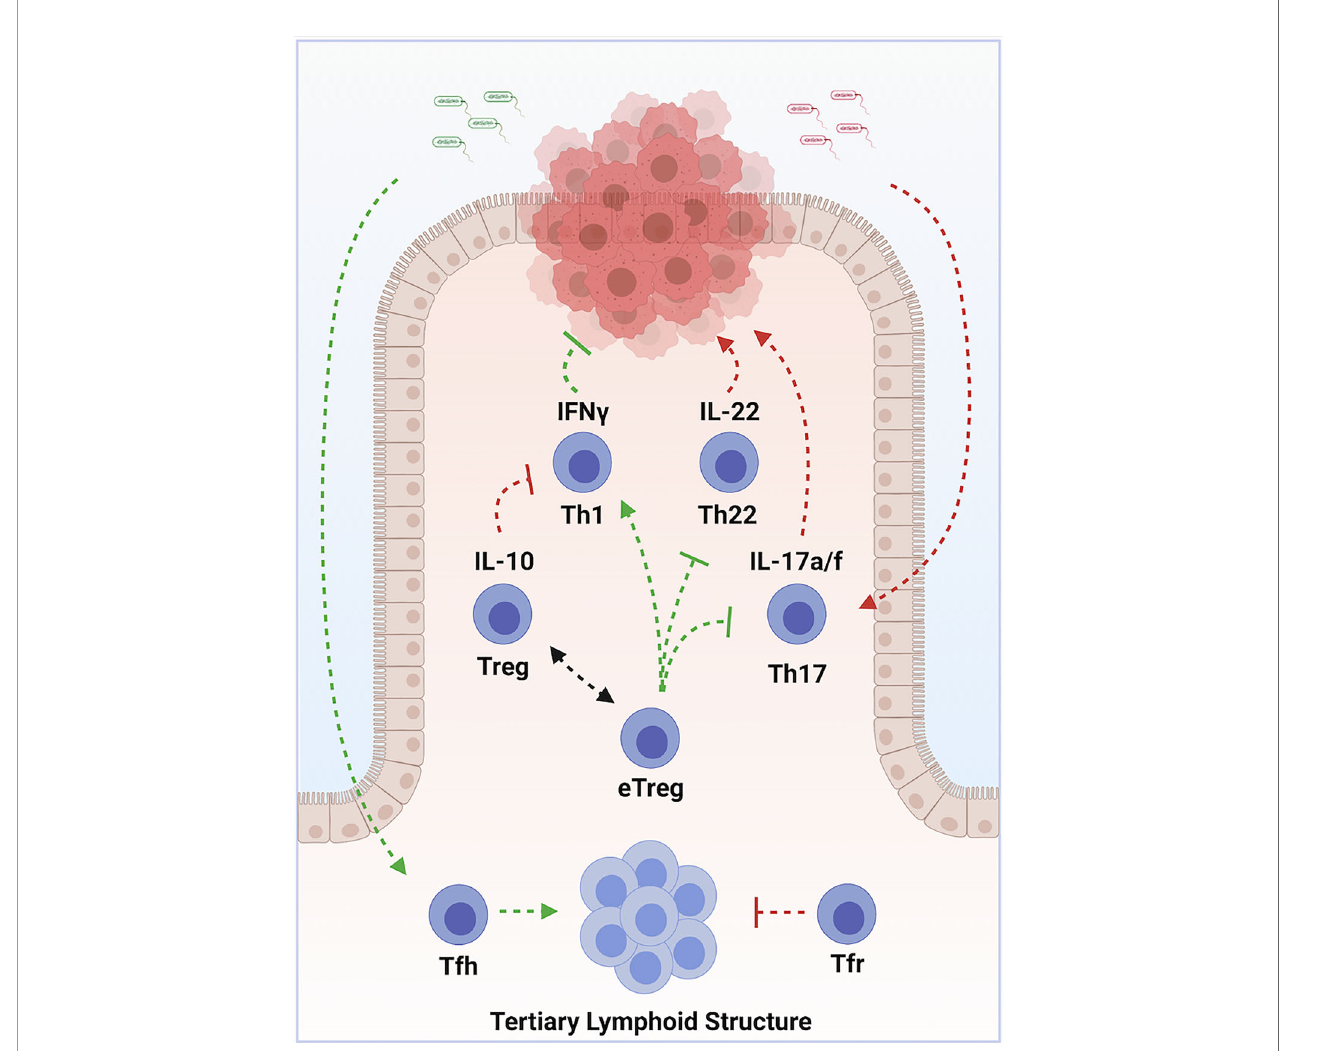
FIGURE 3 | Multilayered roles of various subsets of CD4 + T Cells in Colorectal Carcinoma. Chronic in fl ammation, driven by Th17 cells in response to commensal organisms, promotes tumor development. Sustained exposure to IL-22, produced by Th22 cells, contributes to tumorigenesis. Th1 cells promote tumor cell destruction via production of IFN- g . Treg cells oppose tumor development by suppressing chronic in fl ammation, but contribute to progression by opposing optimal tumor responses. Some types of pro-in fl ammatory eTreg cells, in contrast, promote tumor immune responses. Tumor colonization by protective commensal species drives accumulation of Tfh, which organize tertiary lymphoid structures. These structures enhance tumor immune responses and predict responses to chemo- and immune-therapeutics. Arrows indicate positive modulation; perpendicular lines indicate inhibitory relationships. Green indicates an overall anti-tumor effect, while red indicates an overall pro-tumorigenic effect. Created with